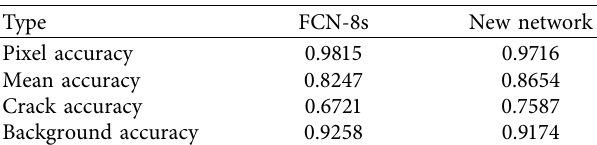
Table 2: Results of various types of detection for FCN-8s and